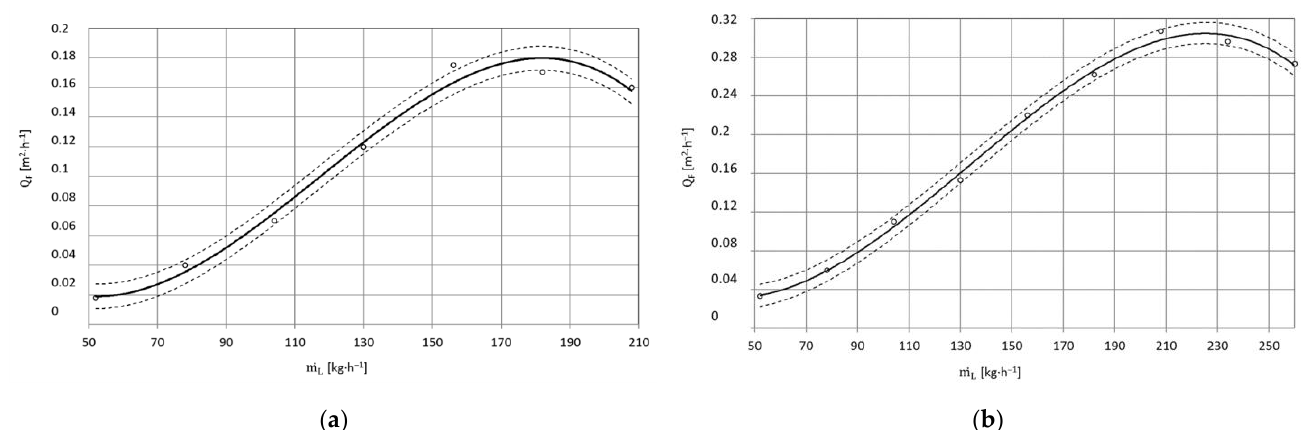
Figure 12. Influence of dry ice CO 2 output m L [kg · h − 1 ] on maximum surface efficiency Q F [m 2 · h − 1 ] of paint coat stripping by high-pressure water-ice jet from PA2 aluminium alloy surface (TS = 4×1.2 mm, L k = 200 mm, l 2 = 250 mm, κ = 90°): ( a ) Jet pressure p w = 20 MPa; ( b ) p w = 35 MPa.